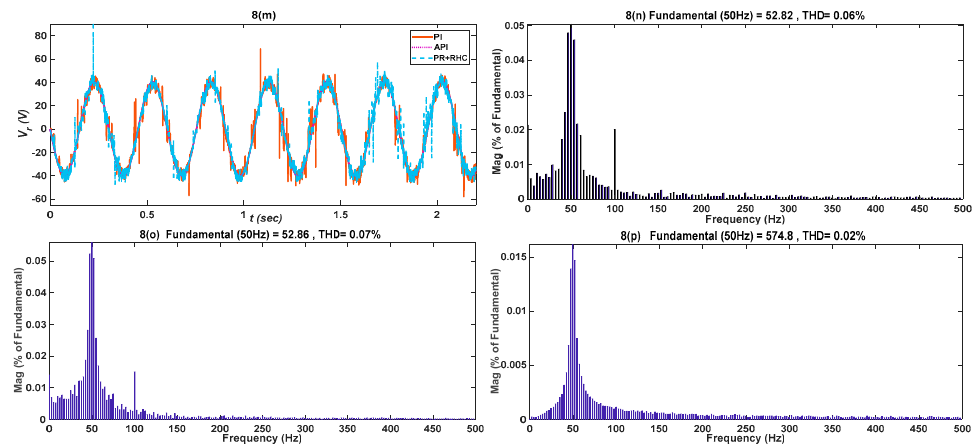
Figure 8. Comparison of PI and Proposed API and PR+RHC controllers responses under rated voltage, considering: ( a ) Dc-link voltage V dc ; ( b ) Stator voltage V s ; ( c – e ) Active component of current I d ; ( f ) Rotor current I r ; ( g ) Reactive component I q ; ( h ) Grid current I g ; ( i ) Stator active power P s ; ( j ) Rotor active power P r ; ( k ) Electromagnetic torque T em ; ( l ) Stator reactive power Ps react ; ( m ) Rotor voltage V r ; ( n ) PR+RHC controller THD; ( o ) PI controller THD; ( p ) API controller THD. Table 2. Performance evaluation of designed control strategies for V dc . Control Strategies